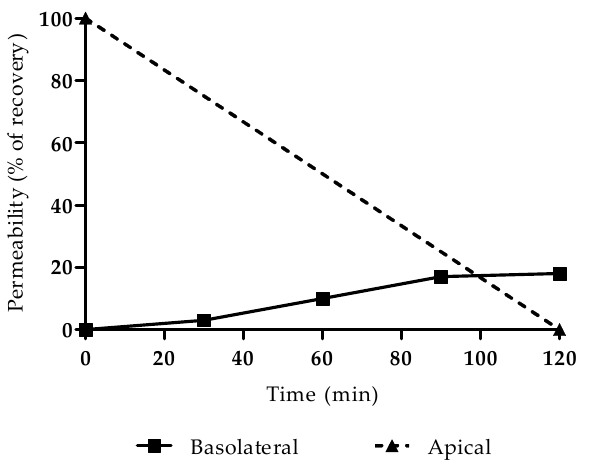
Figure 2. Permeability of gemcitabine, expressed as the percentage recovered in the basolateral and apical compartments.